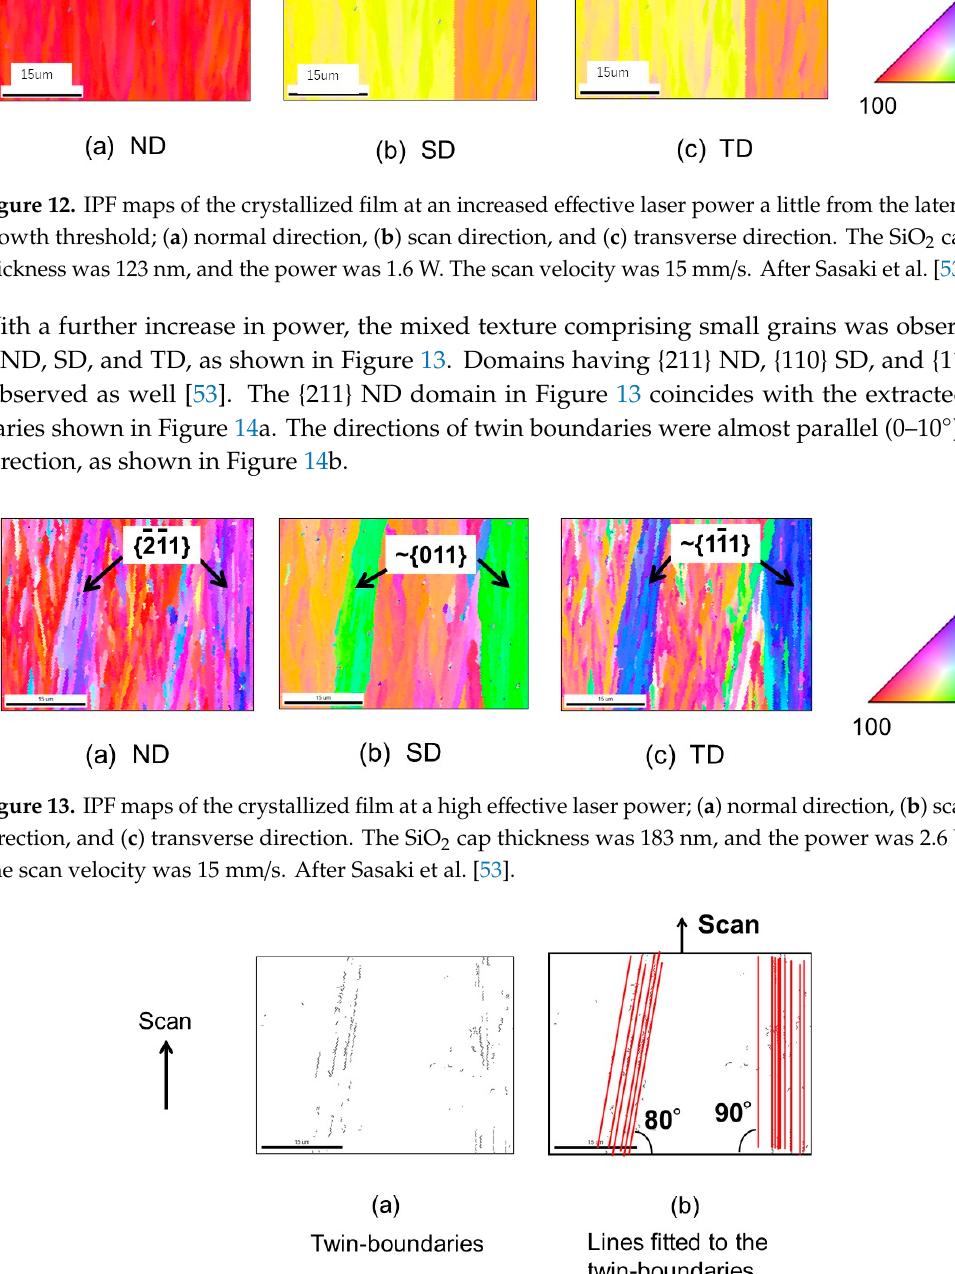
8 of 17 Figure 11. Distribution of surface direction around {100}. ( a ) IPF plot and ( b ) surface direction chart. 99.8% of the crystallized region is {100} ND-oriented within 10 ˚ . The SiO 2 cap thickness was 123 nm, and the power was 1.4 W. The scan velocity was 15 mm/s. After Sasaki et al. [52]. When the laser power was increased to 1.6 W with the same cap thickness and the same scan velocity, the IPF ND texture remained in {100}, but in-plane SD and TD textures changed from {100} and domains parallel to the scan direction were formed, as shown in Figure 12 [44,49,53]. The